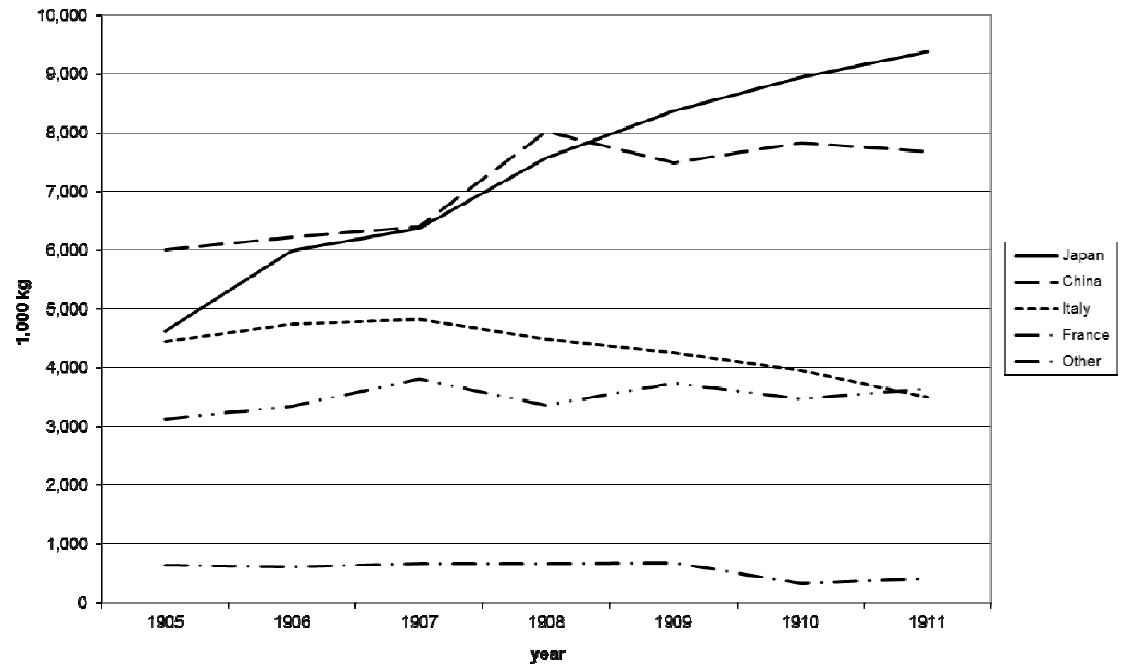
Figure 2. Raw Silk Production in the World,